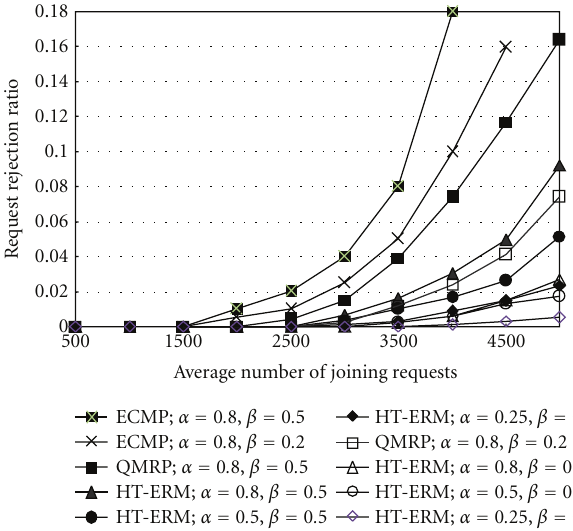
Figure 8: Request rejection ratio versus group joining